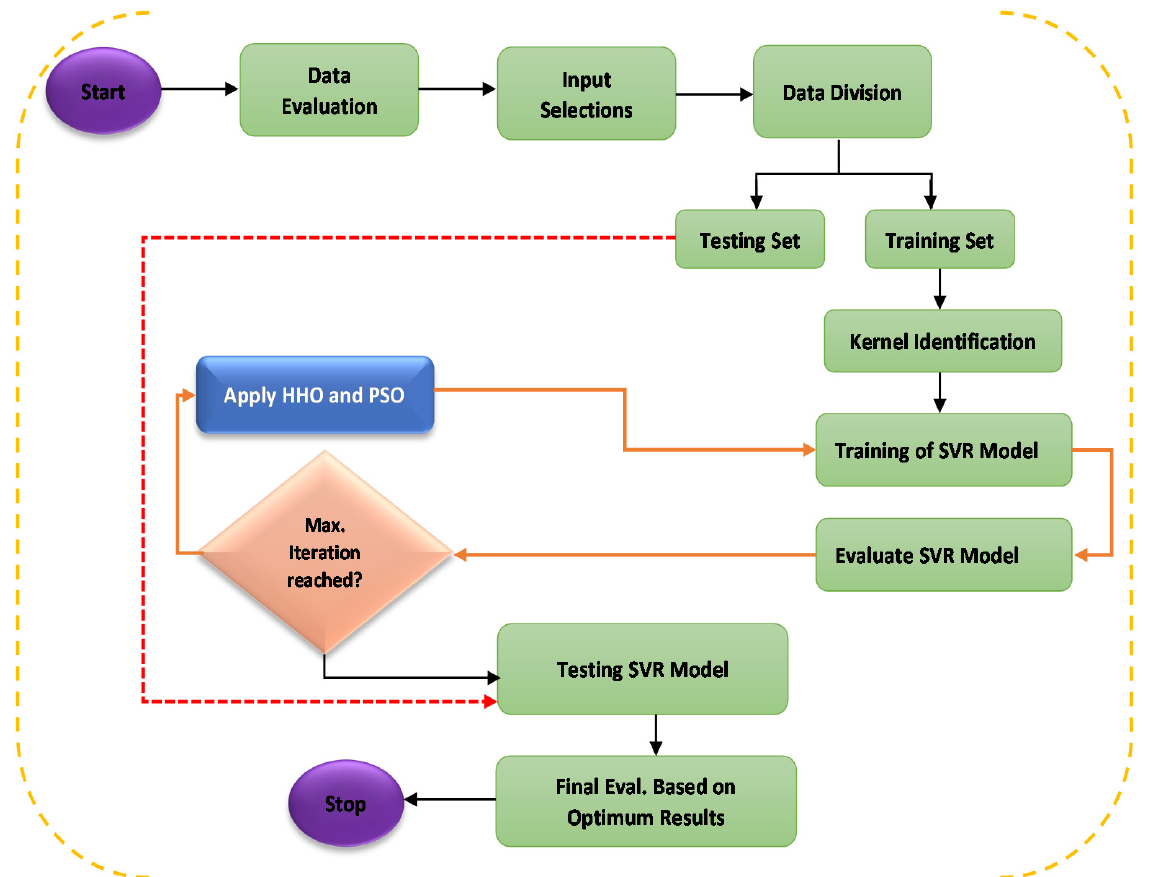
Figure 3. Flowchart of the proposed hybrid support vector regression models. The data values were divided into two sets for the development of prediction models (i.e., SVR-HHO, and SVR-PSO): one set for model training, and another set for testing.